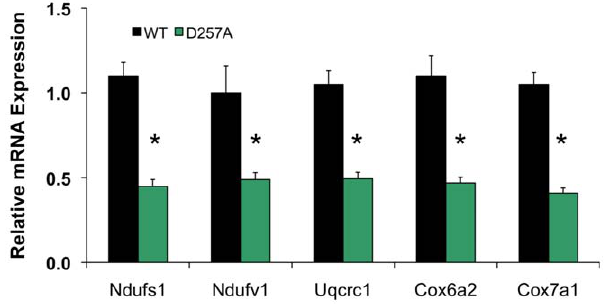
Figure 4. D257A mice display decreased mRNA expression of nuclear genes encoding components of ETC Complexes I, III and IV. Relative mRNA expression of genes encoding components of the ETC complexes I, III and IV, including Ndufs1, Ndufv1, Uqcrc1, Cox6a2 , and Cox7a1 was measured in the skeletal muscle from WT and D257A mice at 13 months of age by quantative RT-PCR (n=5 per group). Mean values 6 SEM are shown. *p , 0.05.